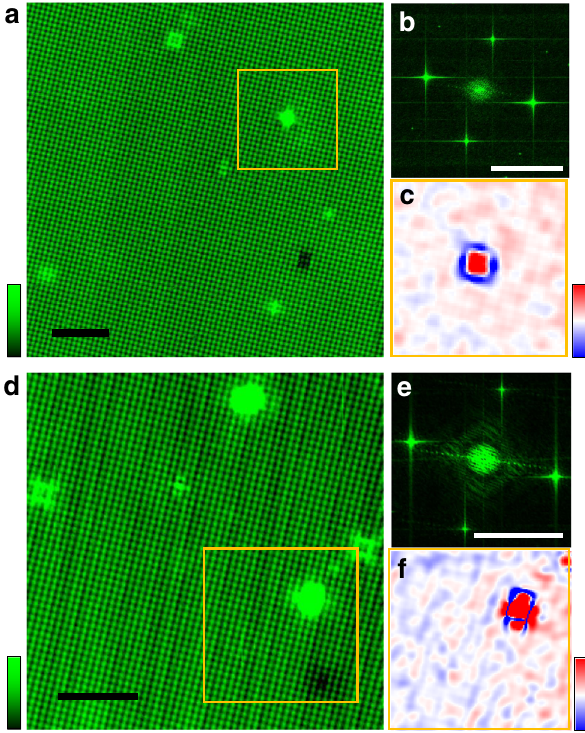
Fig. 3 Absence of modulated in-plane strain. In a we show a topographic image (tunneling current of 0.2 nA and bias voltage of 9 mV). The corresponding Fourier transform is shown in b . In c we show the in-plane strain map of the orange square shown in a . In d we show the topography of another fi eld of view (tunneling current of 0.5 nA and bias voltage of 4 mV), in e its Fourier transform and in f the strain on the area marked with an orange square shown in d . Black scale bars in a , d are 5 nm long. White scale bars in b and e are 3 nm − 1 long. The color scale of the topographic images is shown on the bottom left of a and d and goes from 0 pm (black) to 20 pm (green). The color scale of the strain is shown on the bottom right of c and f , and ranges ±5% of the in-plane lattice constant a